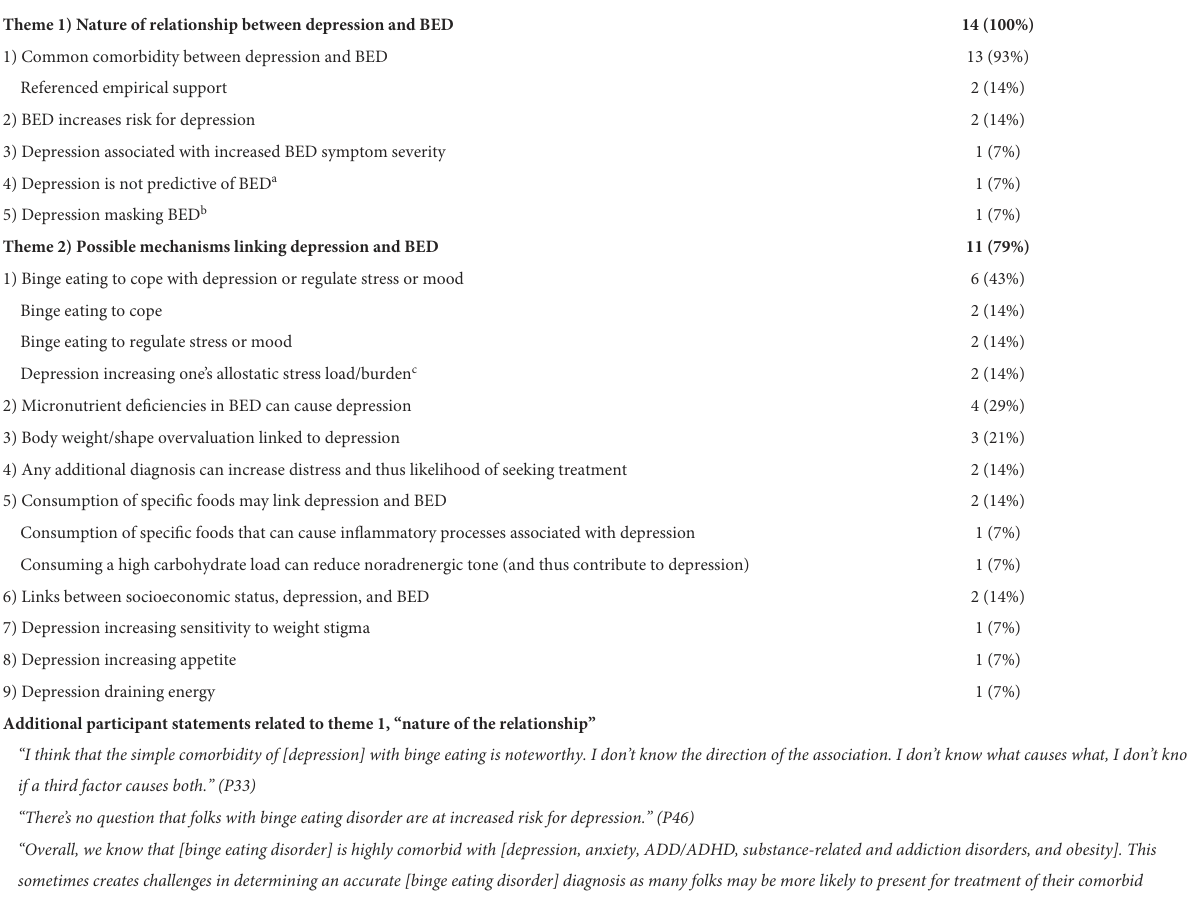
TABLE 4 Participant statements relating domain 1, “depression” to binge eating disorder pathology